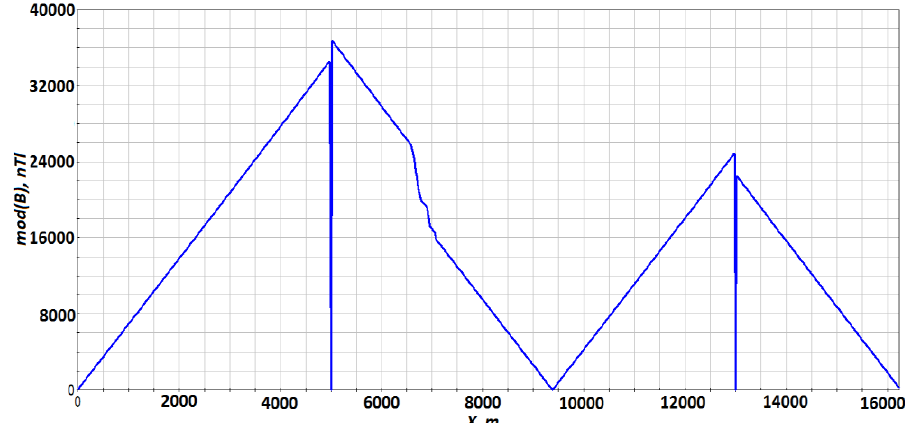
Figure 3. Module of magnetic induction vector (T) at height of 1 m. in the air over the pipeline